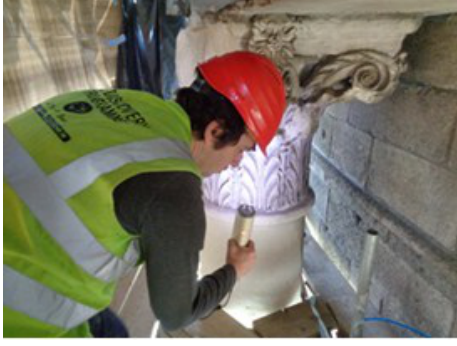
Figure 4: Structured Light Scanner